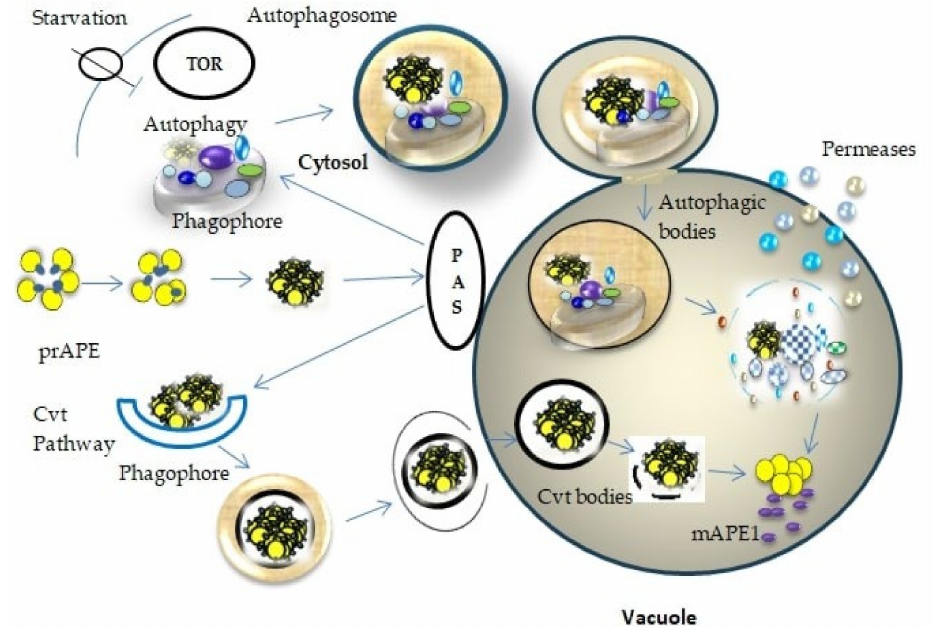
Figure 2. Schematic diagram of the autophagosome at a cellular level. Once the autophagy started induction, the phagophore assembled at PAS. The autophagosomal bodies fuse with the vacuole, releasing the autophagic bodies. These bodies are degraded by hydrolytic enzymes and exported into the cytoplasm for